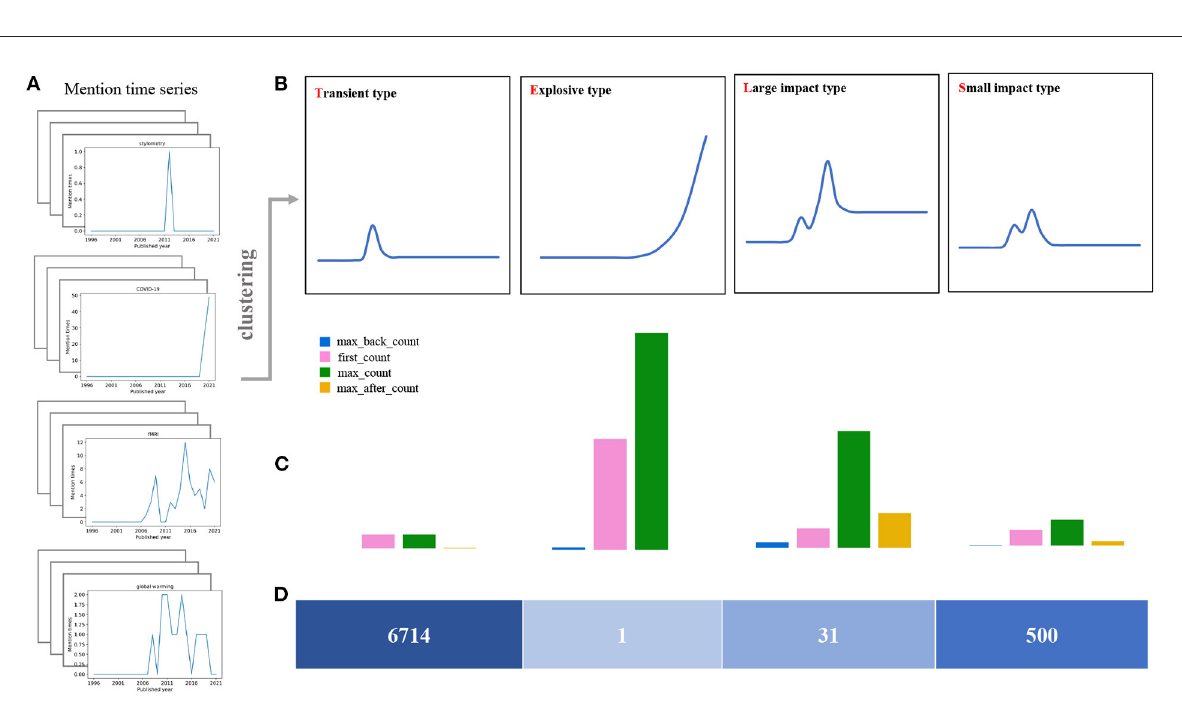
FIGURE4 Cluster analysis of mention time series. (A) Four keyword mention time series examples in the data set. (B) The average mention time series for each cluster, which corresponds to the four keyword evolution patterns present in the dataset. (C) Cluster centroids are plotted as bars, and the height of the vertical axis corresponds to the value of each feature. (D) The number of keywords in each